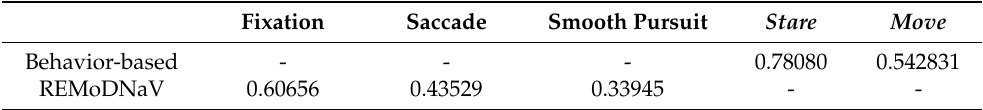
Figure 12. Comparison of abstract gaze movement visualizations according to the gaze-parsing algorithms. ( a ) The visual stimulus with the eye movement task of an observer. The observer pauses for 3 s at the points where the green nodes are drawn during the eye movement. ( b ) The raw gaze points. ( c ) The abstract gaze movement visualization with the behavior-based gaze data processing method using AlexNet. The abstract gaze movement visualizations with I-VT in ( d-1 – d-3 ), I-DT in ( e-1 – e-3 ), and DBSCAN with IQR in ( f-1 – f-3 ) are presented. Table 2. F1 scores of machine learning-based gaze-parsing